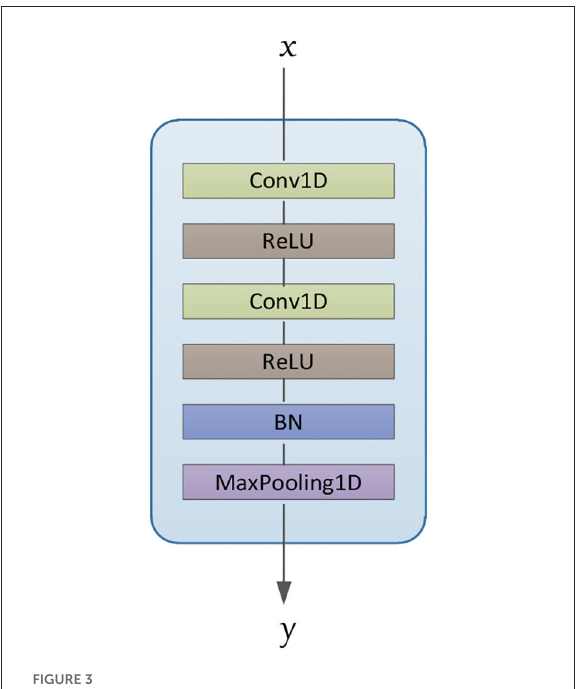
FIGURE3 Architecture of convolutional